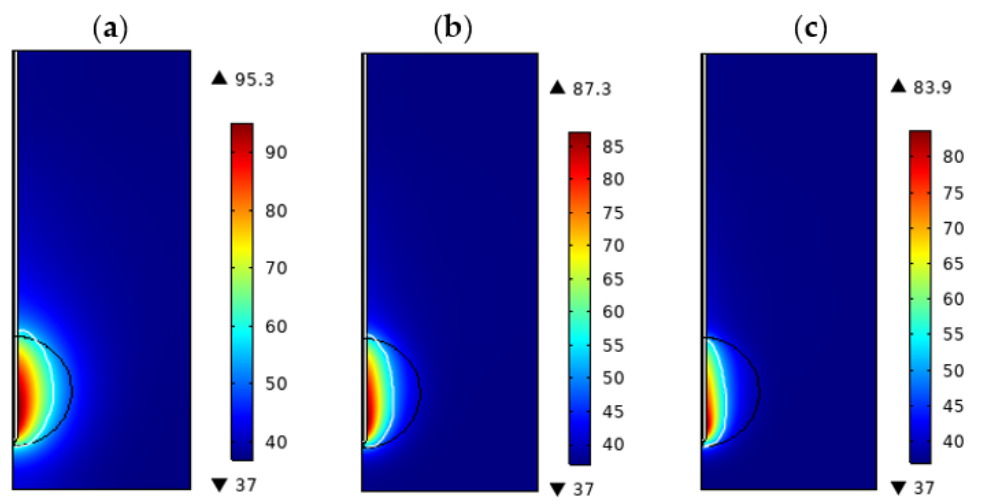
Figure 4. Temperature distribution of porous lung tissue at different porosity of tumor (P = 10 W, t = 300 s, d = 2.0 cm, φ l = 0.7): ( a ) φ t = 0.5 ( b ) φ t = 0.6 ( c ) φ t =